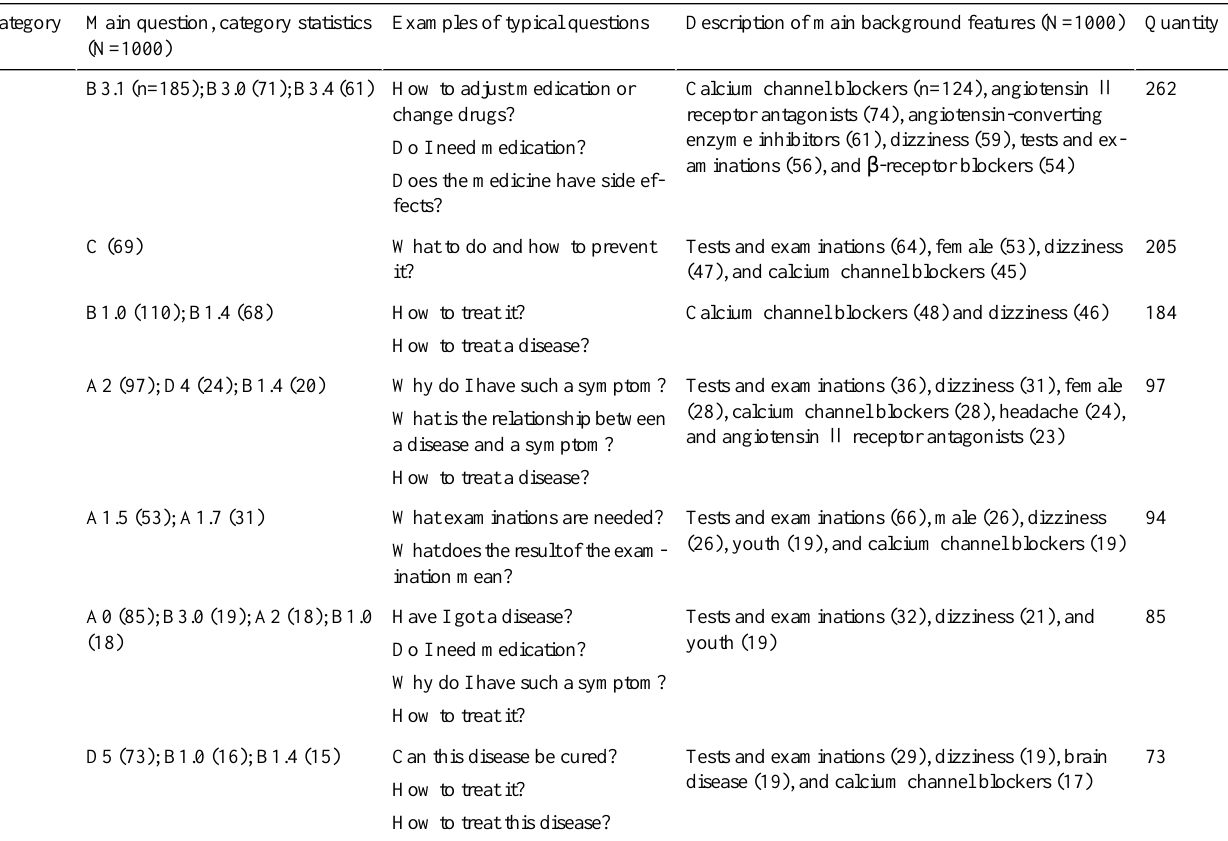
Table 4. Classification of the health information needs of patients with hypertension.